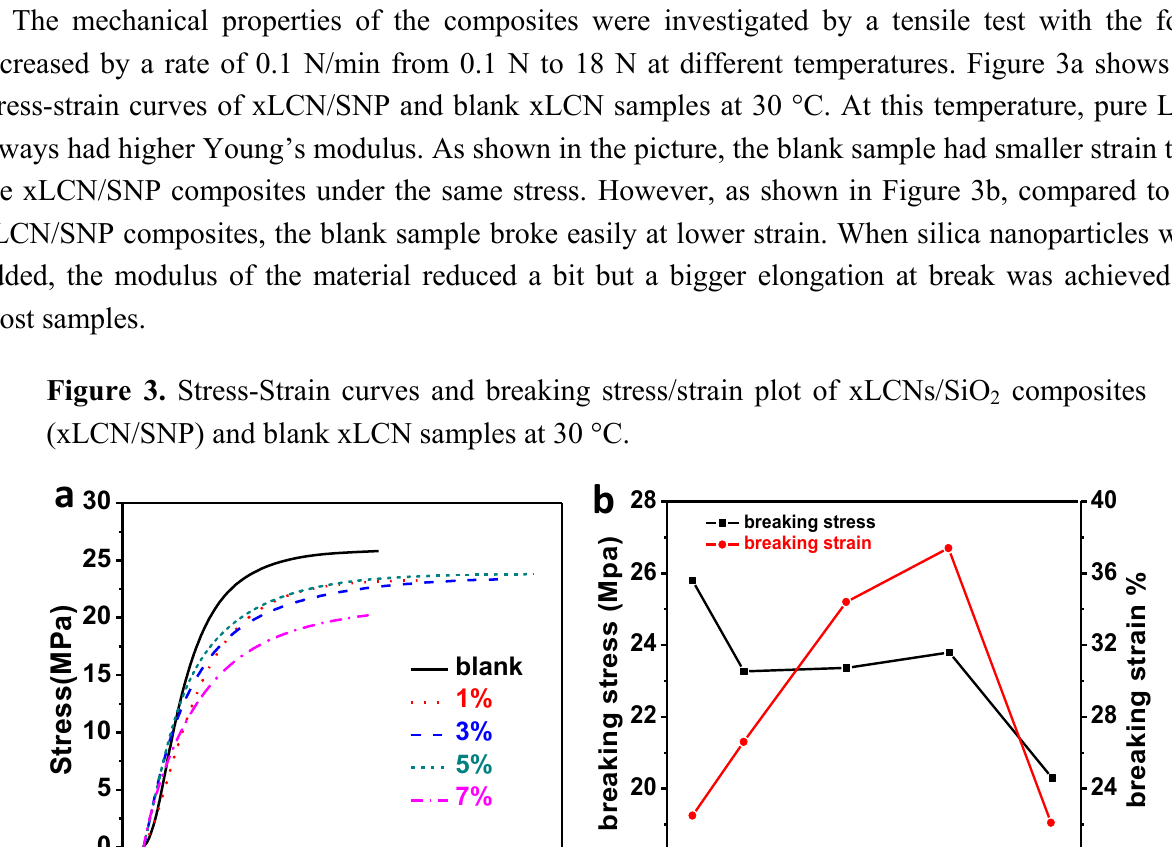
Table 2. Young’s modulus of xLCNs/SiO sample at different temperatures.